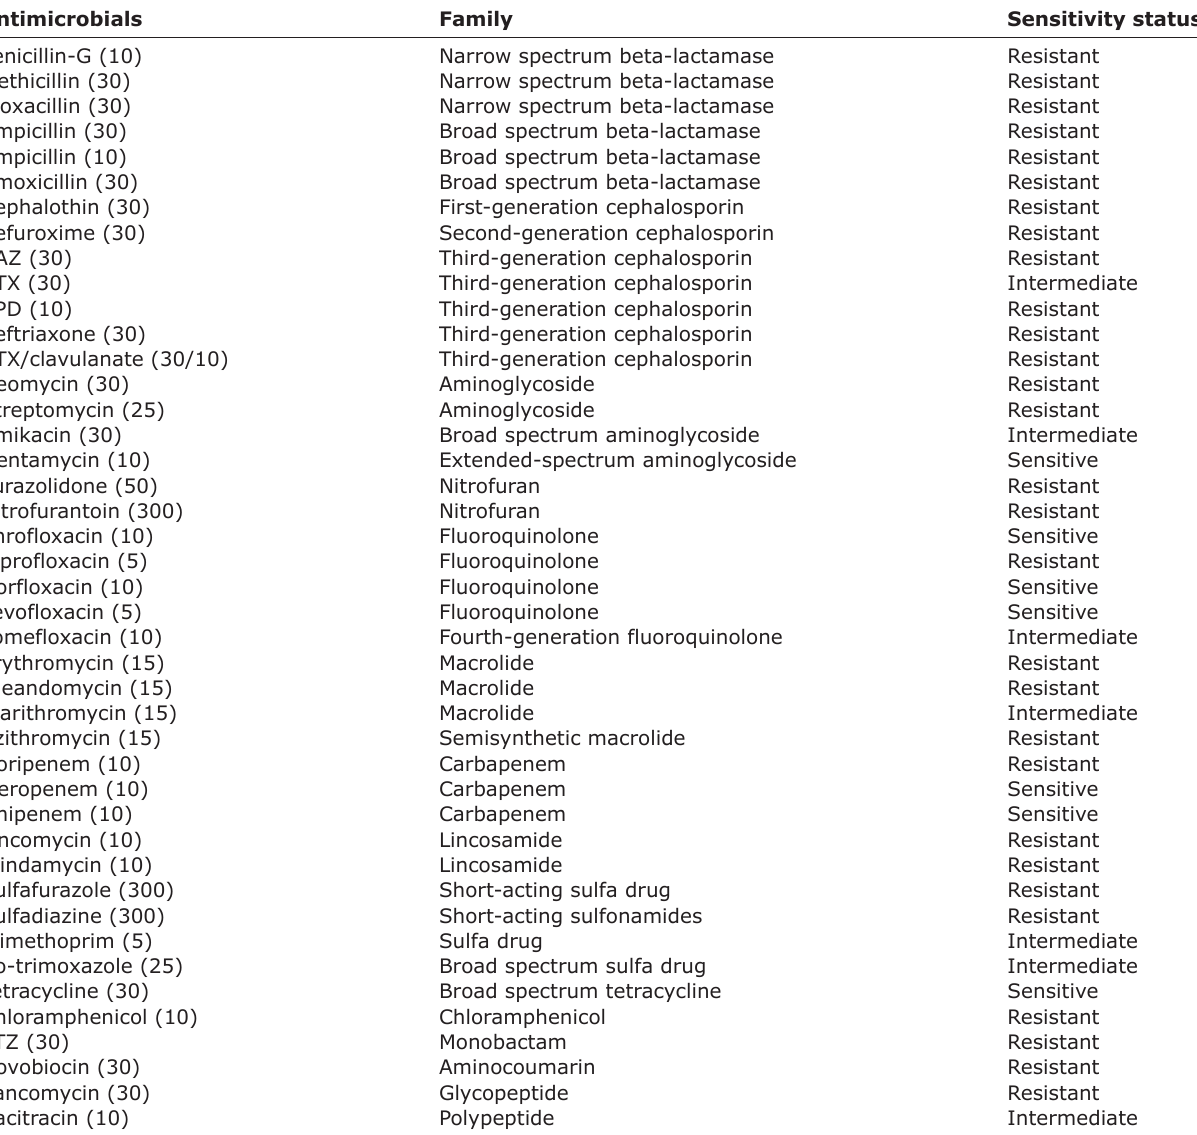
Table-1: Details of antimicrobial sensitivity pattern of five isolates of S. pettenkoferi recovered from peritoneal fluid of cat in India.